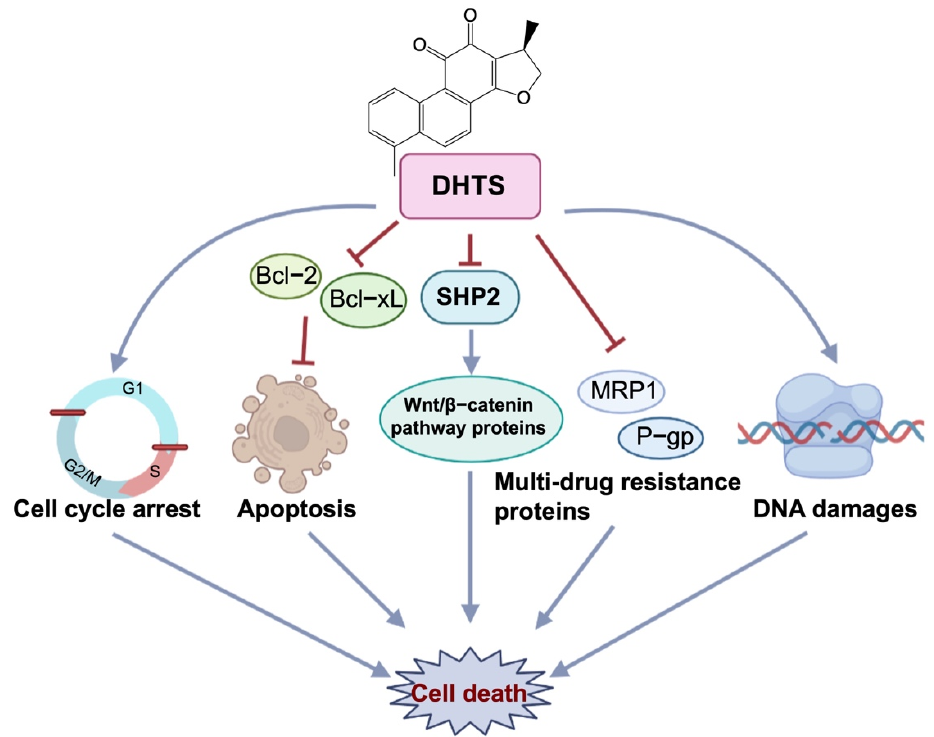
Figure 9. Antitumor effect of DHTS on OXA-resistant CRC. DHTS can exert anti-OXA-induced CRC resistance through multiple links and targets, including blocking the cell cycle in S and G 2 /M phases, promoting apoptosis, inducing DNA damage, and reducing MRP1, P-gp, Bcl-2, Bcl-xL, SHP2, and β -catenin protein.